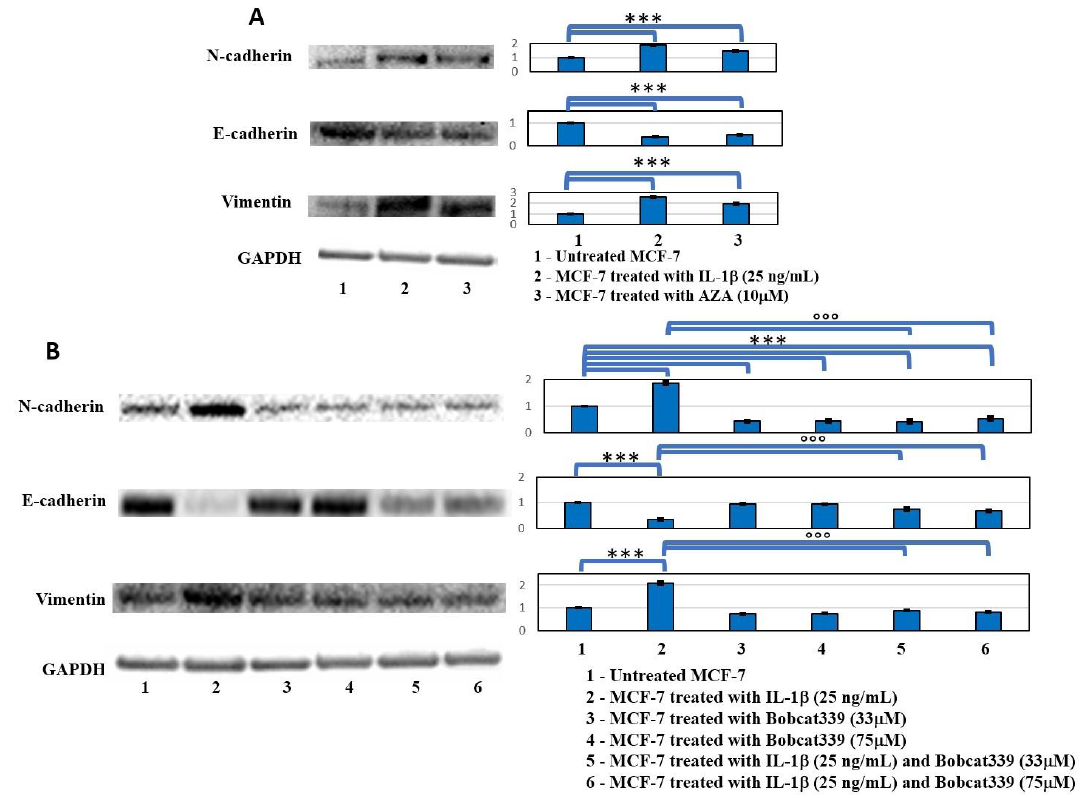
Figure 4. Western blot analysis of EMT markers. ( A ) Western blot analysis of EMT markers in MCF-7 cells untreated and treated with IL-1 β and AZA after 48 h. Representative images of WB of N-cad, Vimentin, and E-cad, and relative densitometric analysis (Mean ± SD). One-way ANOVA showed significant effect of treatment on densitometric data ( p < 0.0005); significant differences were highlighted among tested treatments ( p < 0.0005). ( B ) Western blot analysis of markers that were modified in EMT process in MCF-7 cells untreated and treated with IL-1 β and Bobcat339 (33 µ M and 75 µ M) and relative co-treatments after 48 h. Representative images of WB of N-cadherin, Vimentin, and E-cadherin, and relative densitometric analysis (Mean ± SD, n = 3). One-way ANOVA showed significant effect of treatment on densitometric data ( p < 0.0005); significant differences among tested treatments versus untreated MCF-7 (*), and among IL-1 β /BC co-treatments versus the IL-1 β one ( ◦ ) are reported in the graphs (*** and ◦◦◦ , p <